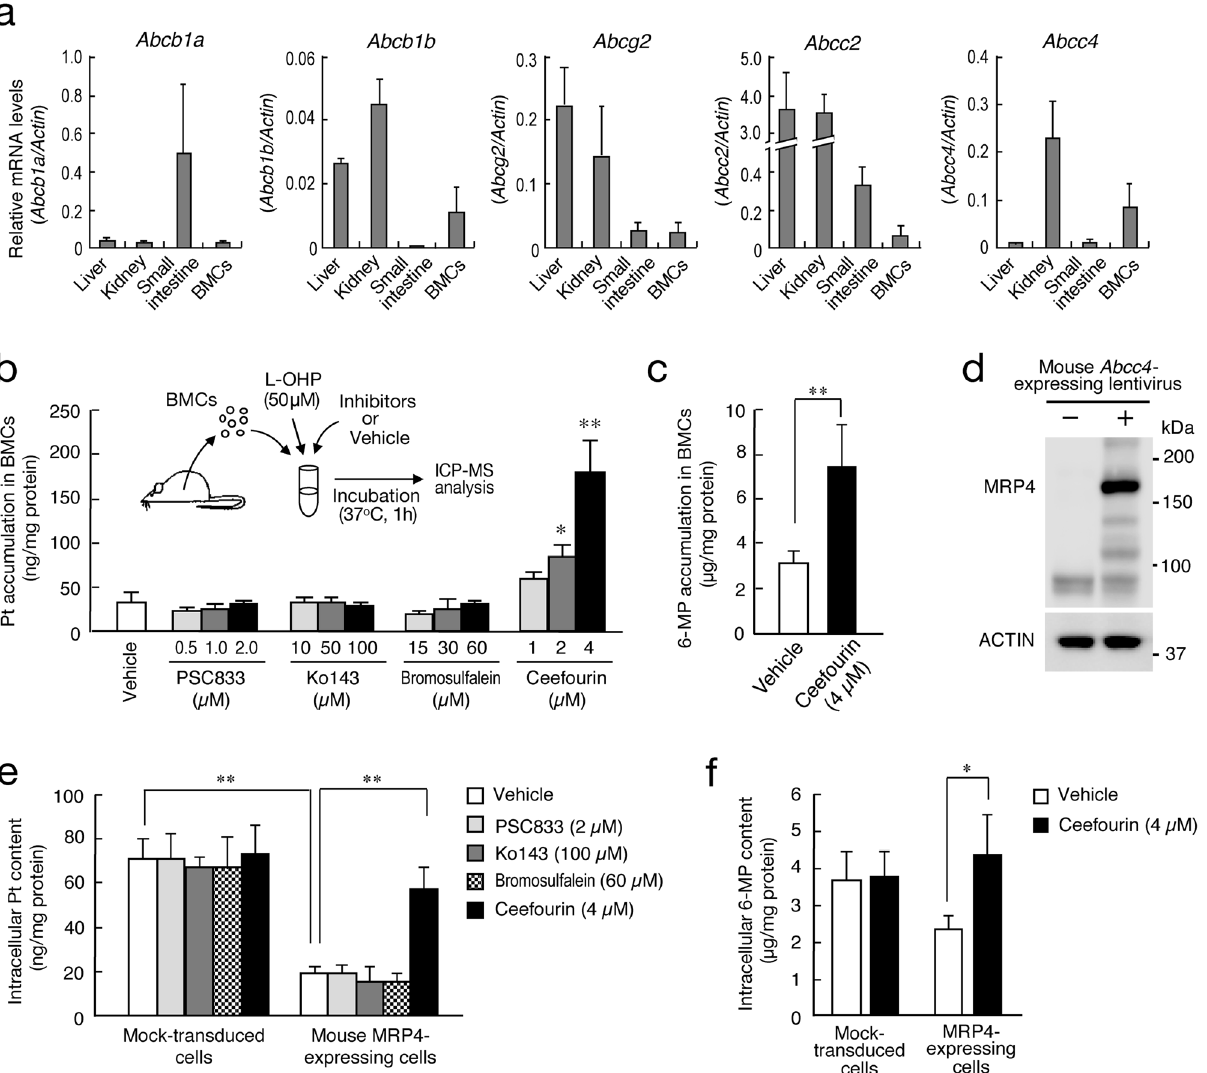
Figure 1. Role of MRP4 in the extrusion of L-OHP from BMCs of mice. ( a ) The mRNA expression of ABC transporters in the liver, kidney, small intestine, and BMCs of mice. The mRNA levels of ABC transporters were normalized to that of Actin. Values are the mean with S.D. (n = 3). ( b ) Effects of ABC transporter inhibitors on Pt accumulation in BMCs after treatment with L-OHP. BMCs were collected from mouse femora. Cells were incubated with 50 μM L-OHP for 1 h in the presence or absence of ABC transporter inhibitors. Values are the mean with S.D. (n = 4). ** P < 0.01; * P < 0.05 significant difference compared with vehicle (0.001% DMSO) group ( F 12,39 = 63.654, P < 0.001, ANOVA with Tukey–Kramer’s post-hoc test). ( c ) Effects of ceefourin on 6-mercaptopurine (6-MP) accumulation in BMCs. BMCs were prepared as described in panel b and treated with 500 µM 6-MP for 1 h in the presence or absence of 4 µM ceefourin. Values are the mean with S.D. (n = 4). ** P < 0.01 significant difference between the two groups ( t 4 = 4.386, P = 0.005, unpaired t-test, two-sided). ( d ) Construction of cells stably expressing mouse MRP4. Lentivirus expressing the mouse Abcc4 gene was transduced into NIH3T3 cells. MRP4 expression was confirmed by Western blotting. Full-size images of western blotting are presented in Supplementary Fig. 4. ( e ) Effects of ABC transporter inhibitors on Pt accumulation in mouse MRP4-expressing cells after treatment with 50 μM L-OHP for 1 h. Values are the mean with S.D. (n = 3). ** P < 0.01 significant difference between the two groups ( F 9,20 = 28.994, P < 0.001, ANOVA with Tukey– Kramer’s post-hoc test). ( f ) Effects of ceefourin on 6-MP accumulation in mouse MRP4-expressing cells. Cells were treated with 50 μM L-OHP for 1 h. Values are the mean with S.D. (n = 4). ** P < 0.05 significant difference between the two groups ( F 3,12 = 28.994, P = 0.018, ANOVA with Tukey–Kramer’s post-hoc